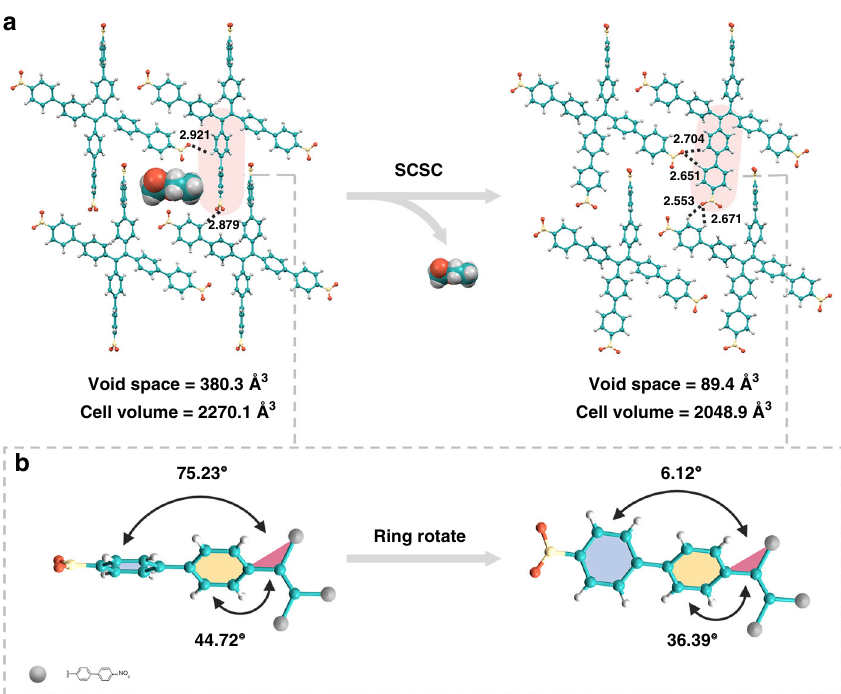
Fig. 3 Single-crystal-to-single-crystal (SCSC) transformation determined by the single-crystal X-ray diffraction. a Structural transformations of the large pore (LP) form in 8PN-EA to the narrow pore (NP) form in 8PN-Heated accompanied by removal of solvent molecules. b Illustration of the signi fi cant changes in the dihedral angles between the plane of the ethylene core and the planes of two different phenyl rings in one arm of TPE-4pn in 8PN-EA and 8PN-Heated due to phenyl